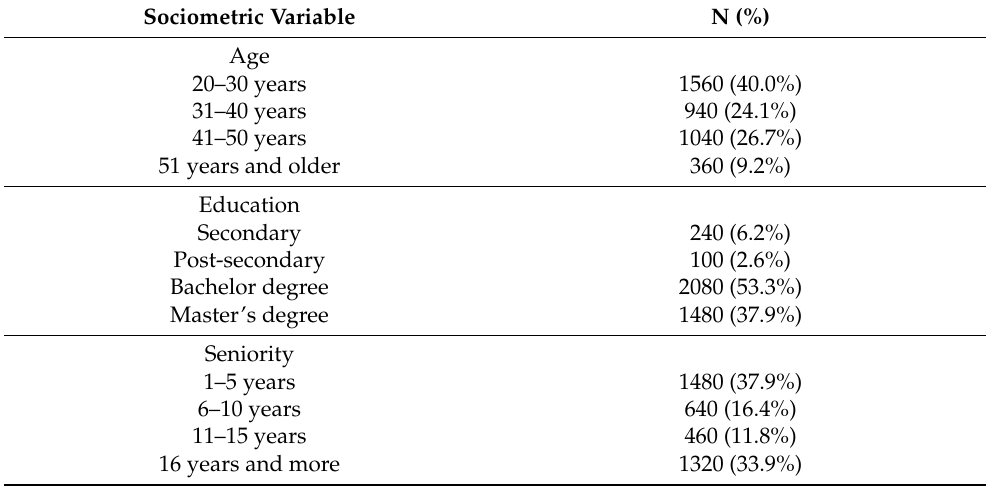
Table 1. Sociodemographic characteristics of the study